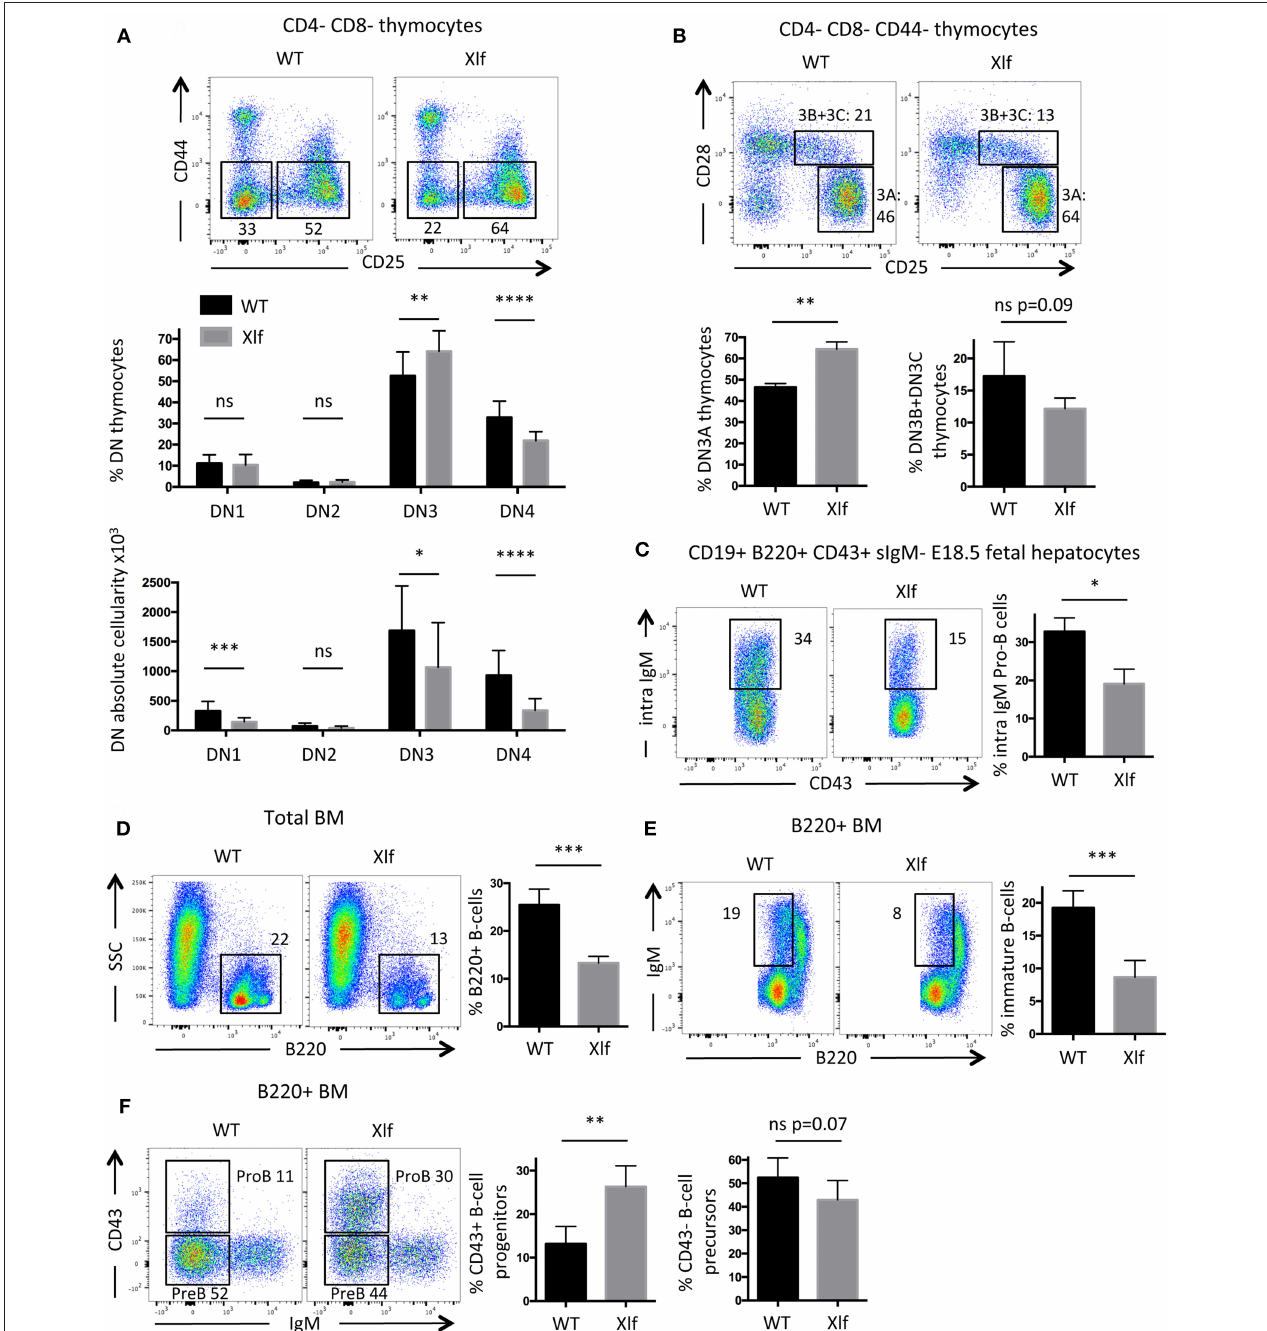
FIGURE 4 | Partial developmental arrest of T- and B-lymphocytes in Xlf − / − mice. (A) Immunostaining and quantification of CD4-CD8- thymocyte populations. DN3 stage is defined as CD44-CD25 + thymocytes and DN4 stage is defined as CD44-CD25- thymocytes. (B) Immunostaining and quantification of CD4-CD8-CD44- thymocyte populations. DN3A stage is defined as CD25 + CD28- thymocytes, during which thymocytes undergo V(D)J recombination at Tcrb locus. (C) Immunostaining and quantification of intracellular IgM expression in E18.5 fetal liver pro-B cells. (D) Immunostaining and quantification of B220 + total B-cells in adult bone marrow (BM). (E) Immunostaining and quantification of immature B-cells in adult B220 + BM. Immature B-cells stage is defined as B220 low IgM + stage, which results from V(D)J recombination at IgH locus in Pro-B cells. (F) Immunostaining and quantification of B220 + CD43 + IgM- progenitors B-cells in adult BM. P -values were calculated using non-parametric Mann-Whitney tests (A–F)